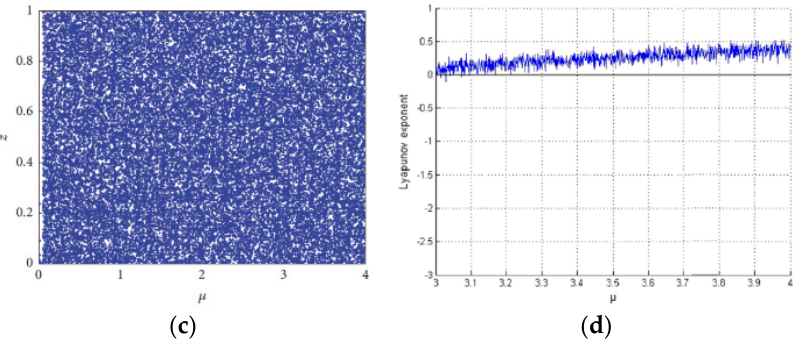
Figure 1. Distribution of intertwining logistic map; ( a ) bifurcation diagram of sequences x; ( b ) bifur- cation diagram of sequences y; ( c ) bifurcation diagram of sequences z; ( d ) Lyapunov exponents diagram.